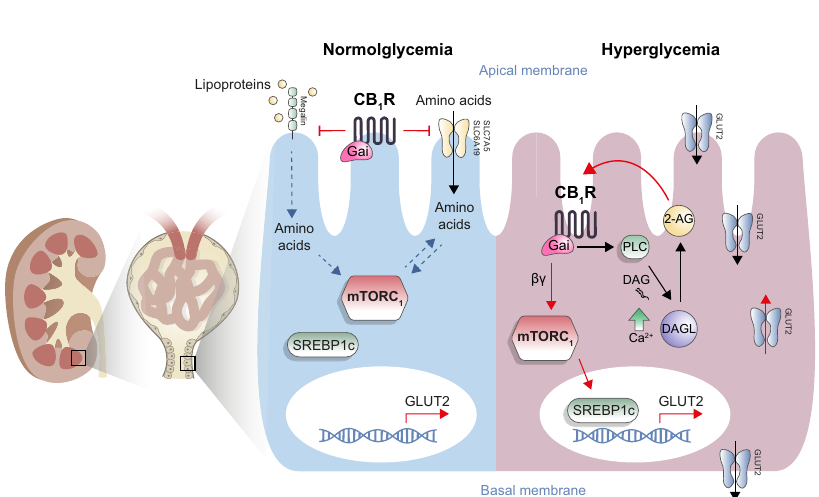
Fig. 8 A proposed mechanism by which renal proximal tubule CB 1 R regulates mTORC1 activity in health and disease. In normoglycemia CB 1 R is responsible to maintain mTORC1 normal activation by preventing excess of amino acids uptake (left). In hyperglycemia, CB 1 R-mediated mTORC1 over- activation results in upregulating GLUT2 transcription, consequently enhancing glucose absorption and tubular damage the development of DKD in Akita-RPTC-GLUT2 − / − mice. Proximal tubular GLUT2 is known to be upregulated and translocated to the brush border membrane of the RPTCs where it facilitates glucose reabsorption during diabetes 55,95 , and may increase glucose-induced tubular damage and tubule-interstitial fi brosis. The contribution of GLUT2 recruitment to the brush border membrane of the RPTCs in facilitating increased glucose reabsorption in diabetes is not clear, since kidney glucose